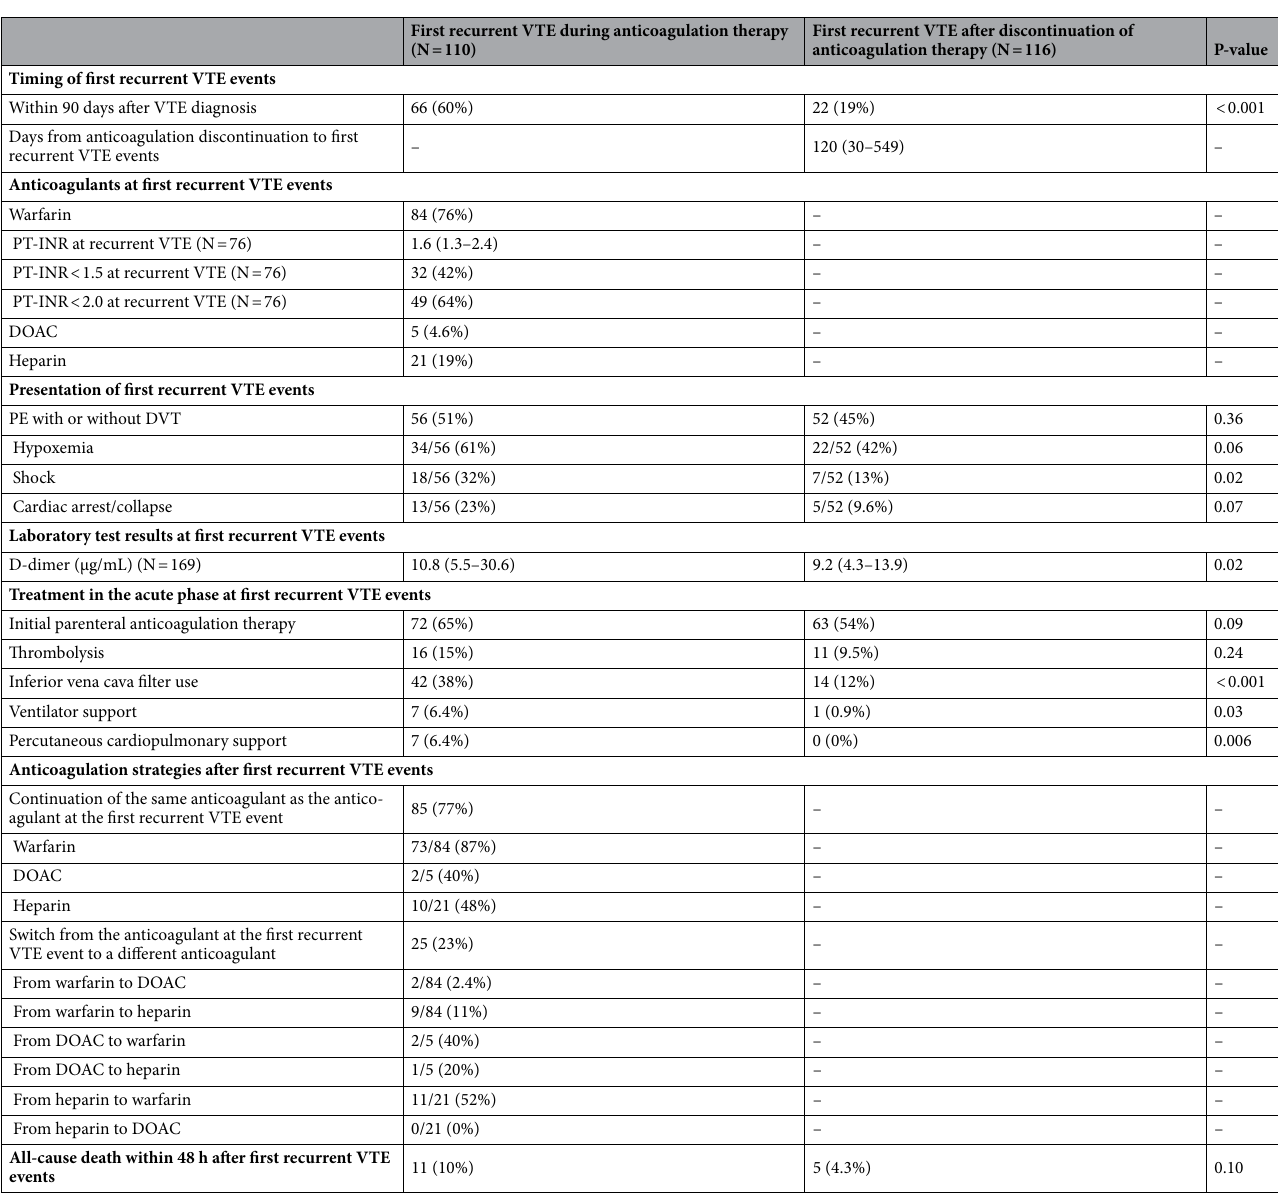
Table 2. Characteristics and management strategies of first recurrent VTE events. Categorical variables are presented as numbers and percentages, and continuous variables are presented as the median and interquartile range. Categorical variables were compared using the chi-squared test when appropriate; otherwise, Fisher’s exact test was used. Continuous variables were compared using Wilcoxon’s rank sum test. VTE